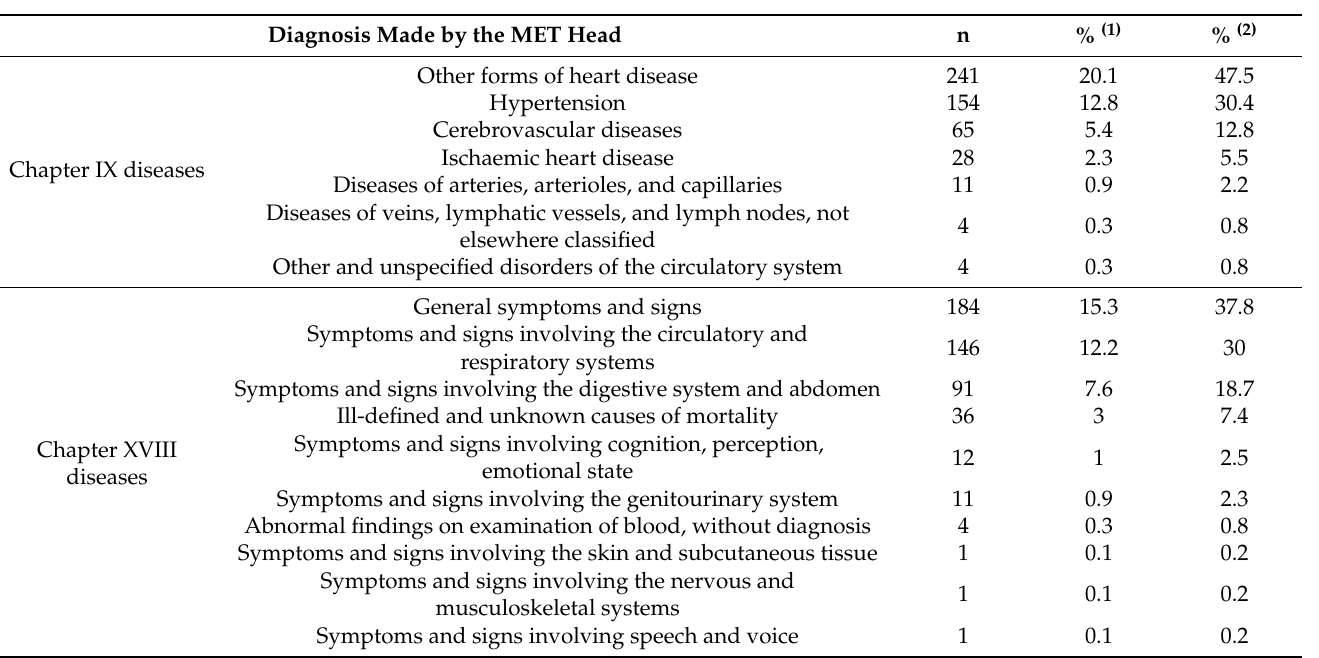
Table 3. The percentage distribution of the frequency of the most common disease groups diagnosed by the MET